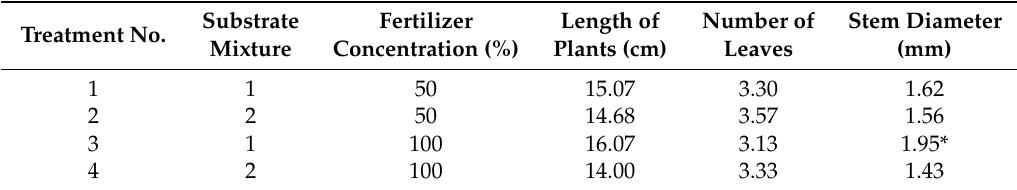
Table 2. Average length, number of leaves and stem diameter of coriander plants for each of the treatments.